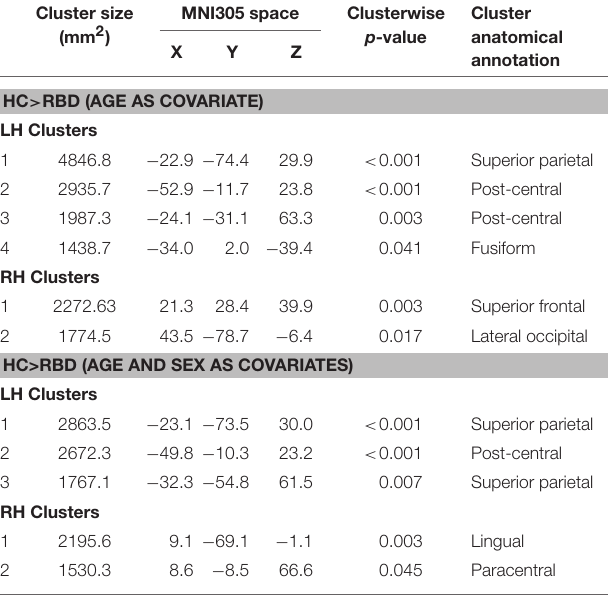
TABLE 3 | Differences between HC and IRBD patients in cortical